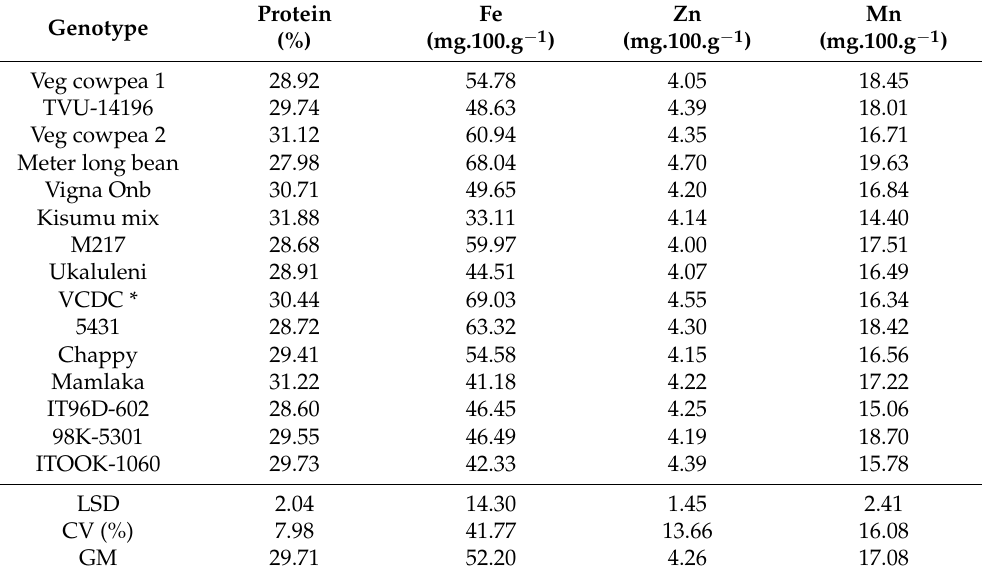
Table 5. Least square means across all environments for each cowpea genotype as well as Least Significant Differences (LSDs), coefficients of variation (CVs), and the grand mean (GM) for each trait.